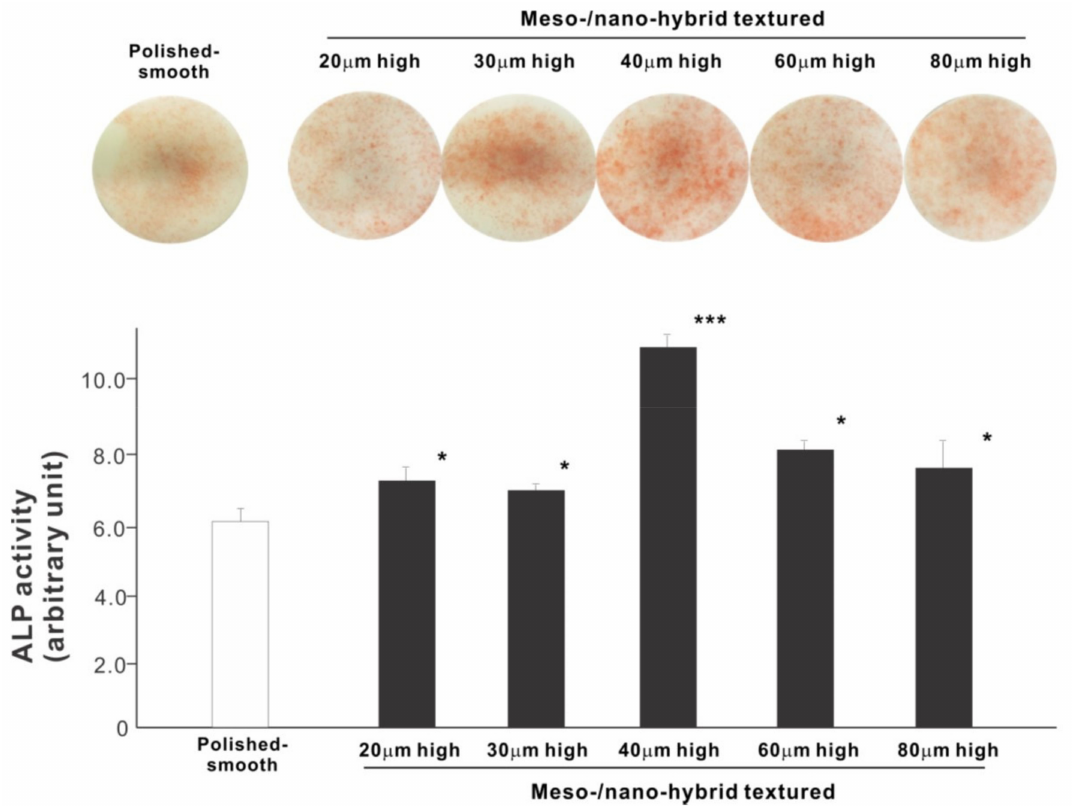
Figure 7. Osteoblastic differentiation on variously textured zirconia surfaces evaluated by alkaline phosphatase (ALP) activity on day 10 of culture. Culture images after ALP staining (top images) and the amount of ALP (histogram) measured by chemical detection are presented. * p < 0.05, *** p < 0.001, statistically significant difference compared with a polished